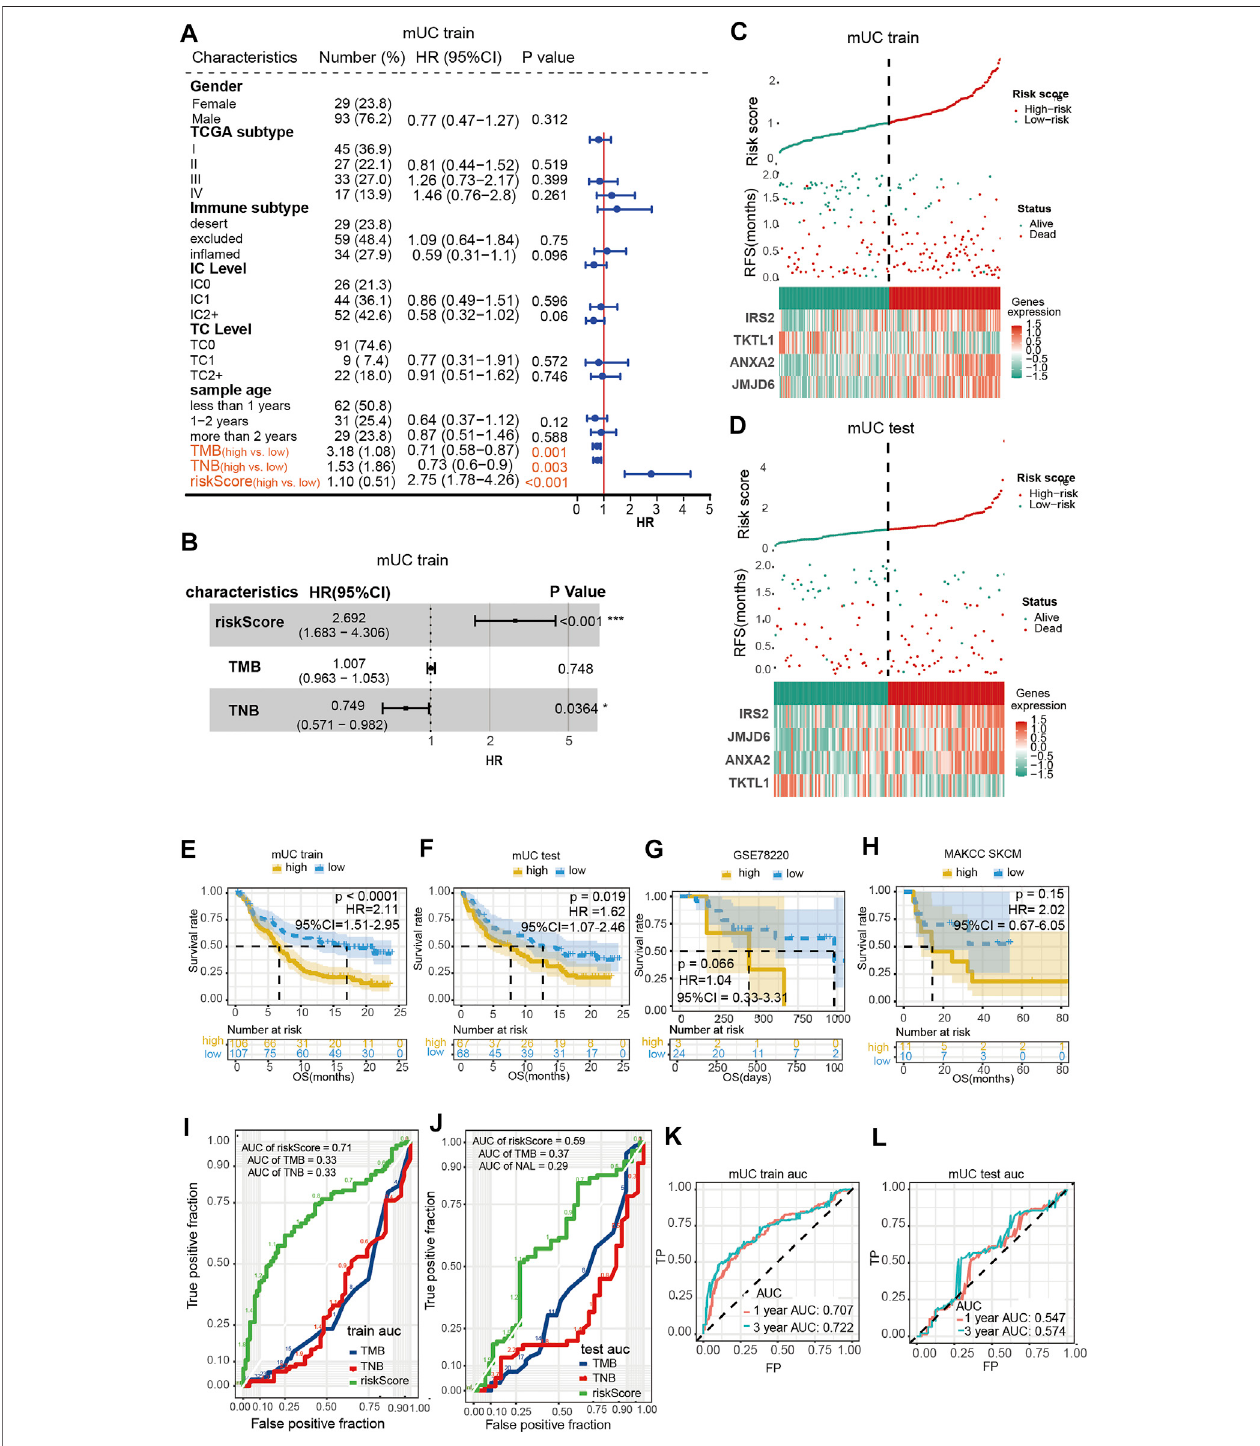
FIGURE 2 | Evaluation of hypoxia risk prognosis model. (A,B) shows the results of a univariate Cox regression and multivariate Cox regression showed that risk score was an independent prognostic factor for patients with mUC treated by ICIs. (C,D) Risk curve showed the relationship between gene expression, hypoxia risk score and survival. (E,H) Kaplan Meier curve showed that the high scores of hypoxia risk were associated with poor prognosis in MUC training set, testing set, MSKCC skcmandGSE78220datasets. (I,L) ROCcurveevaluatedtheAUCvaluesofriskscore,TMBandTNBinthetrainingsetandtestingsetqueue,andthetrainingset had better prediction effect (AUC (cid:1) 0.71). ROC curve was used to evaluate the AUC value of risk score predicting 1-year and 3-year survival rate in the training set and testing set cohort.